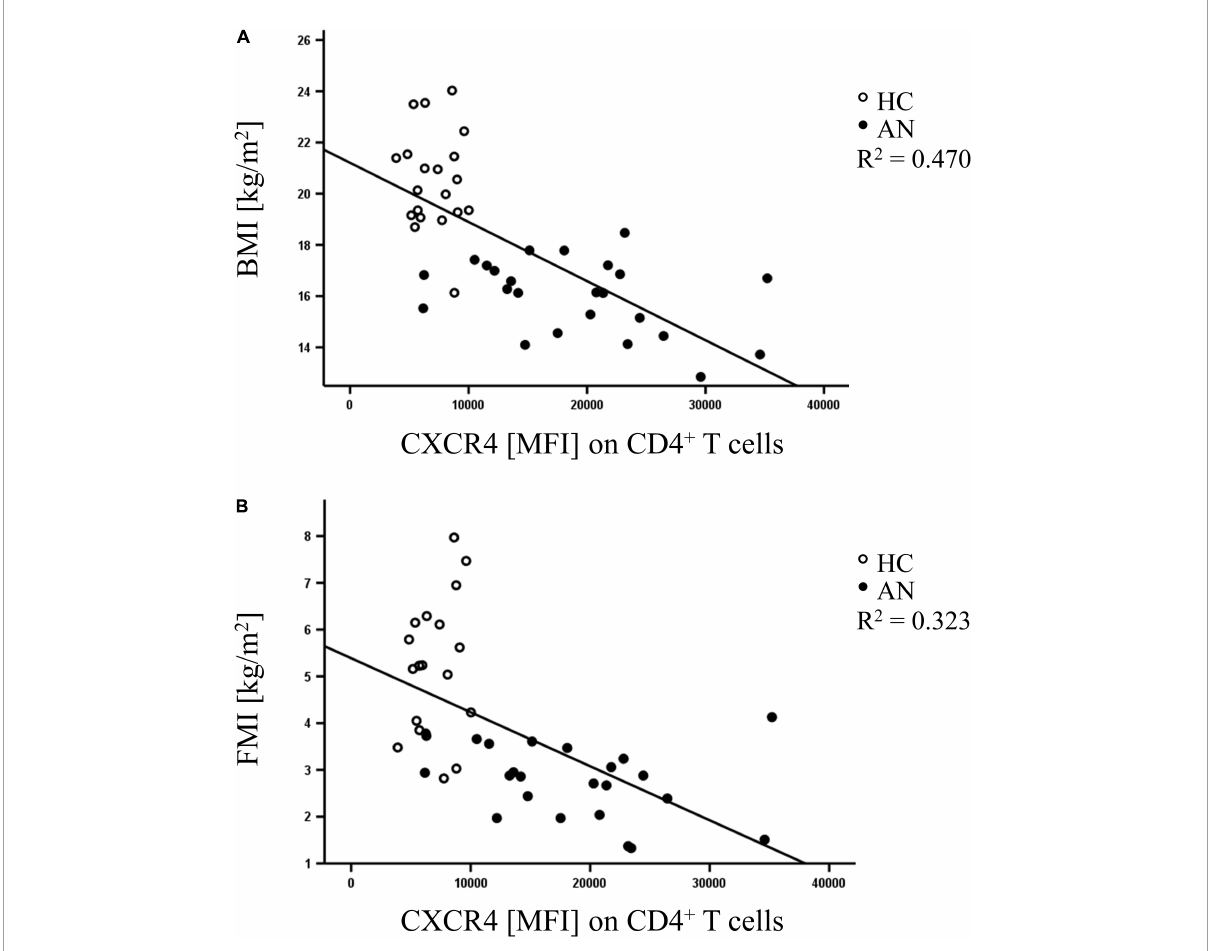
FIGURE2 Scatter diagram depicting direct linear relationships between mean fluorescence intensity (MFI) of CXCR4 on CD4 + T cells and (A) body mass index (BMI), and (B) fat mass index (FMI) in healthy controls (HC: open circle, n = 20) and anorectic adolescents at admission (AN: black circle, n =